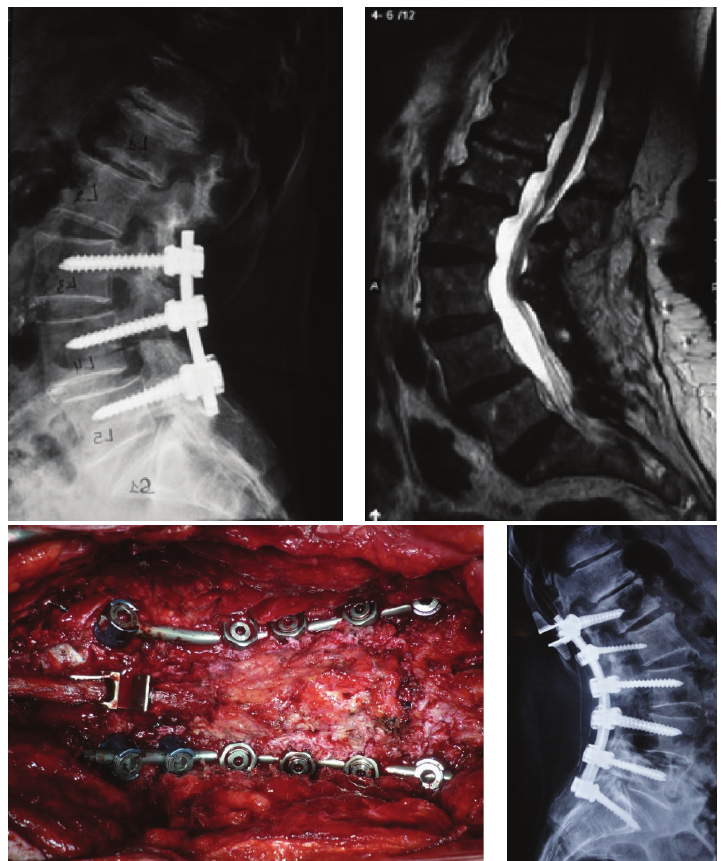
Figure 2: Above preoperative spine X-ray with previous instrumented level on the right. On the left, degenerated segments at L1-L2 and L2-L3 levels. Below preoperative view showing the extended fusion from L1 to S1 with Th12-L1 interspinous